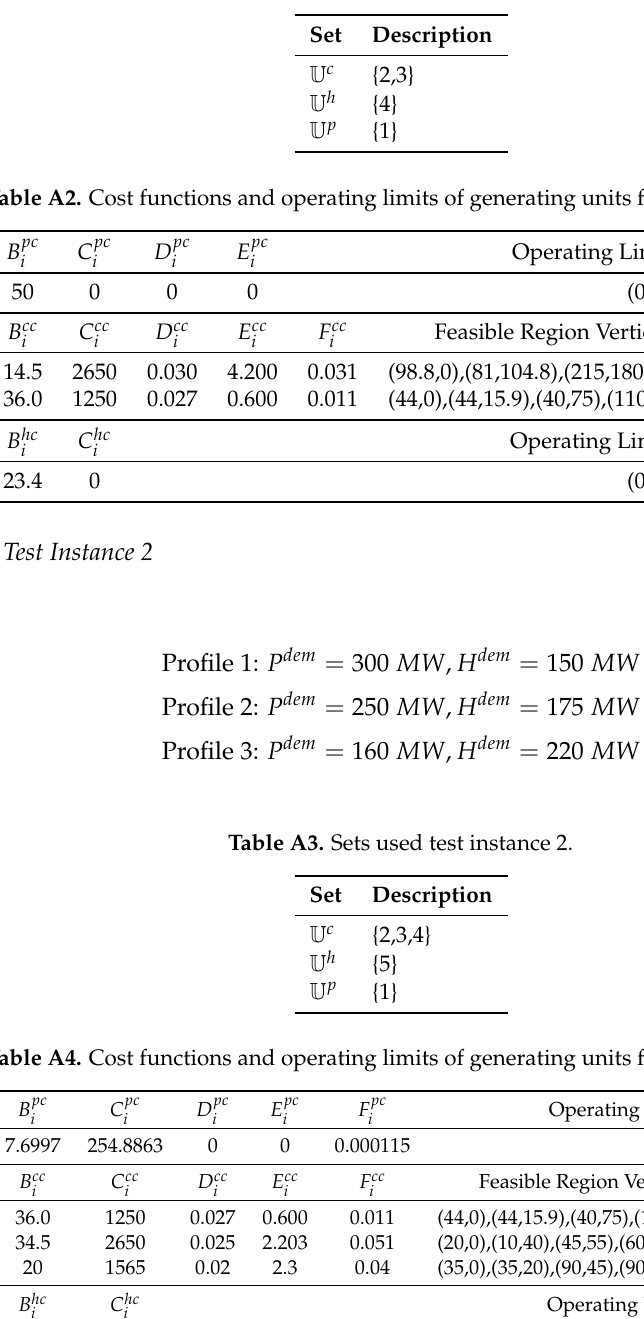
Table A1. Sets used test instance 1.